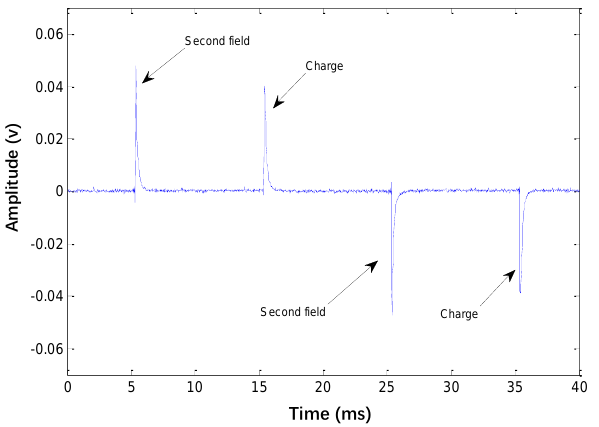
Figure 16. Profile of the open area.